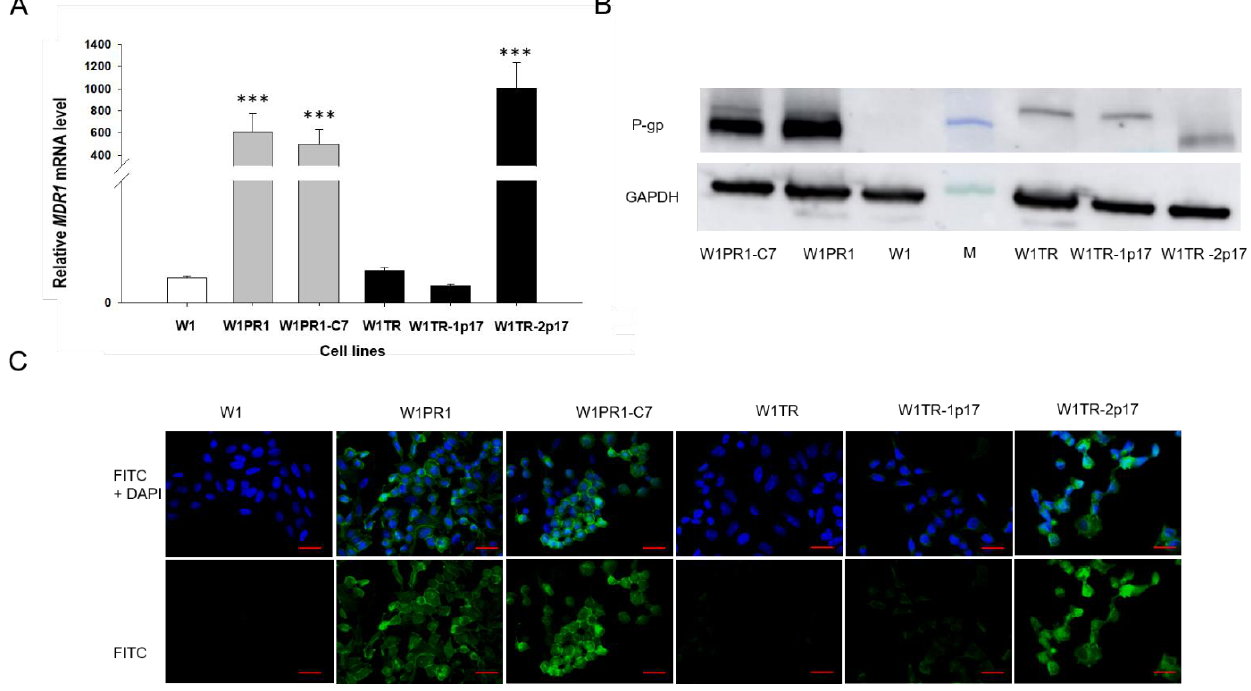
Figure 3. ( A ) Q-PCR analysis of MDR1 transcript expression in the W1 cell line (white bar), W1PR1 and W1PR1-C7 cell line (gray bars), W1TR cell line, W1TR-1p17 and W1TR2-2p17 cell lines